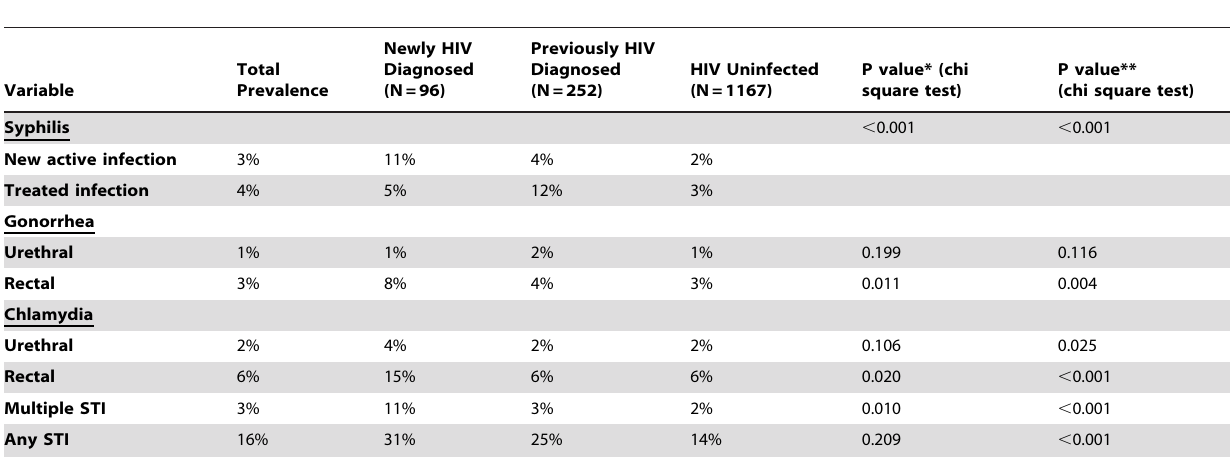
Table 3. Sexually transmitted infections among Black men who have sex with men (participants in HPTN 061) by HIV status: Newly diagnosed versus previously diagnosed or HIV-uninfected at baseline (N =1553).